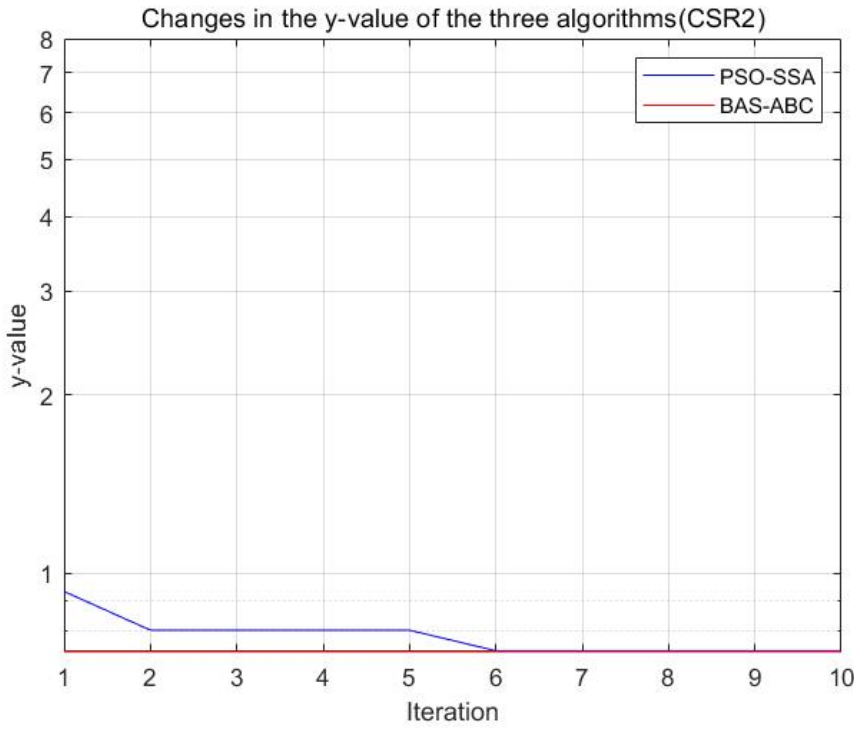
Figure 26. Changes in the 𝑦 value of the two algorithms (CSR2).